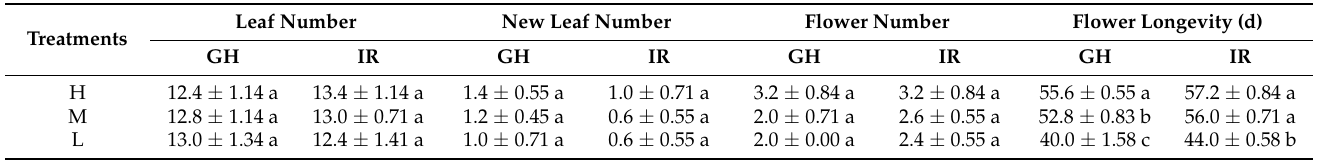
Table 6. Plant morphological differences when grown under a shaded greenhouse and interior